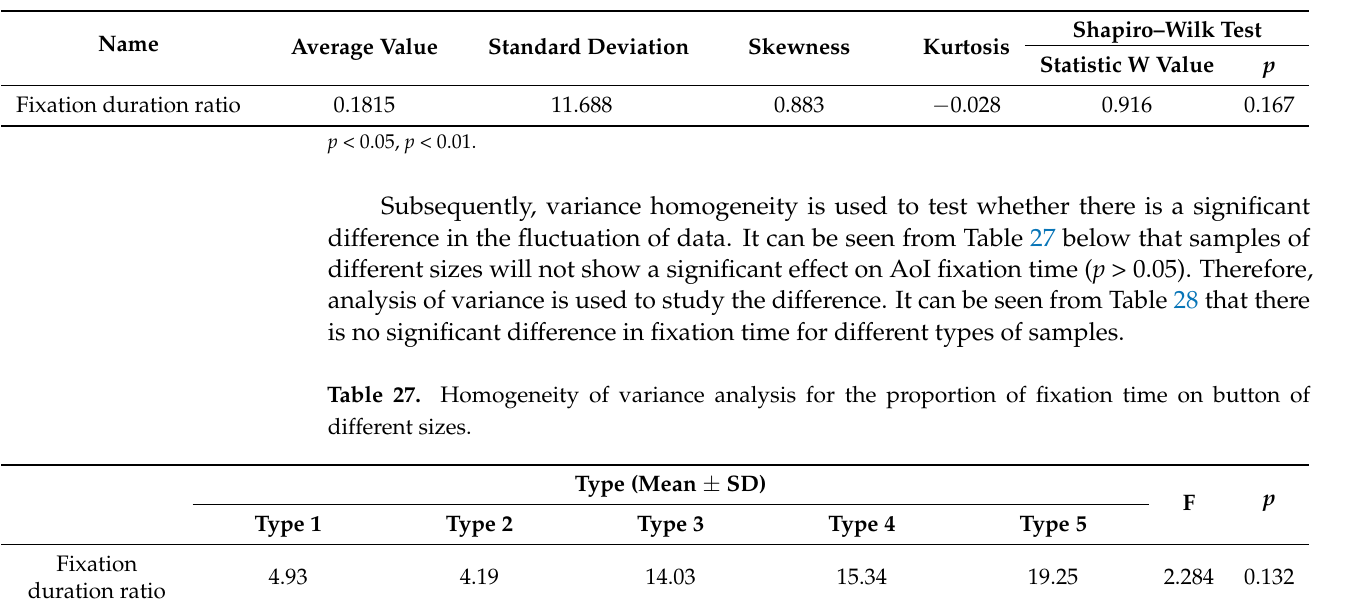
Table 26. The normality test of the proportion of the gaze duration of different sizes of buttons.